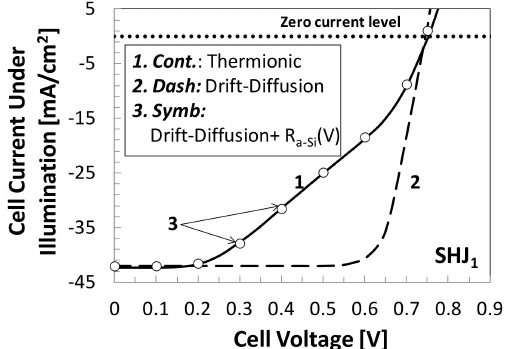
Figure 11. Simulated I-V characteristics under illumination for cell SHJ 1 with 1. thermionic emission transport, 2. drift-diffusion transport, and 3. (Symb) drift-diffusion transport with R a-Si (V) of Table 5 connected in